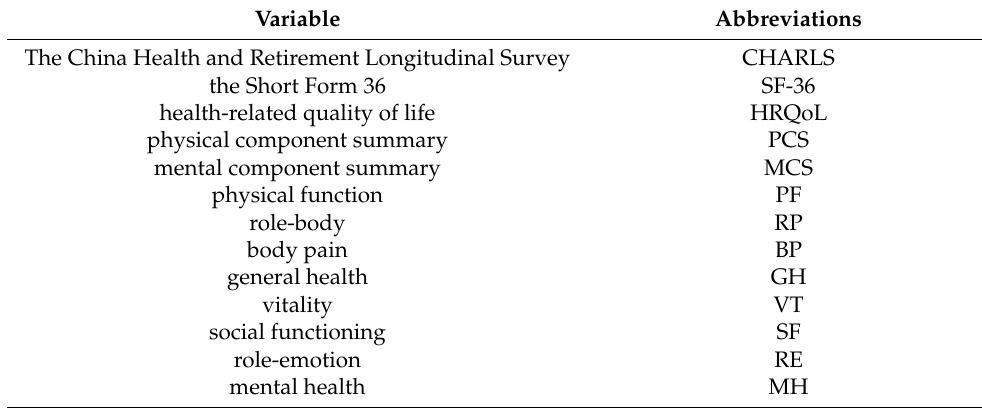
Table 1. The meaning of abbreviations.